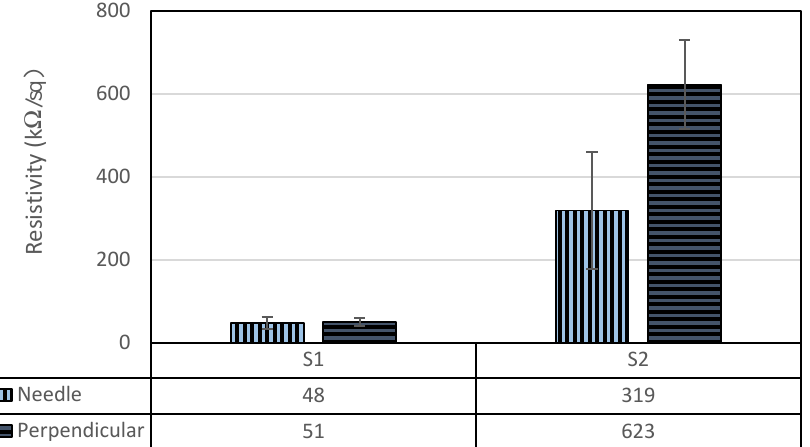
Figure 6. The electrical resistivity of the PPy-coated PCL fibers without (S1) and with plasma treatment (S2). The plasma treatment formed the more stable bond C=N + , which replaced the bonds with high electron freedom, C–N + and –N=.